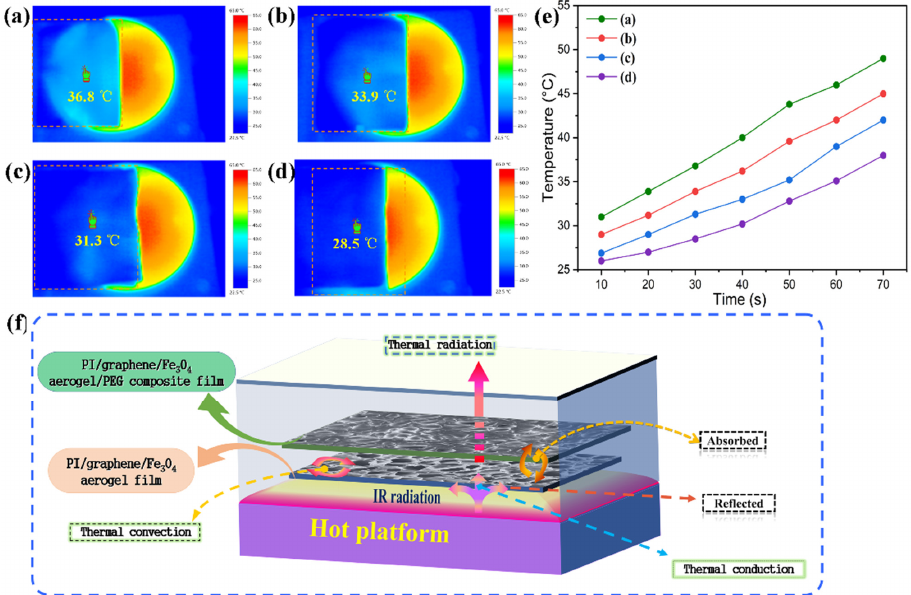
Figure 16. Infrared thermographic images of high-temperature targets partially covered with ( a ) a PI/graphene/Fe 3 O 4 hy- brid aerogel film, ( b ) a PI/graphene/Fe 3 O 4 aerogel/PEG composite film, ( c ) a lower PI/graphene/Fe 3 O 4 hybrid aerogel film and an upper PI/graphene/Fe 3 O 4 aerogel/PEG composite, and ( d ) a PI/graphene/Fe 3 O 4 aerogel/PEG composite film in the middle and two PI/graphene/Fe 3 O 4 hybrid aerogel films on the top and bottom. ( e ) The corresponding plots of surface temperature evolution as a function of time obtained from the infrared thermographic analysis. ( f ) Scheme of IR stealth mechanism for the double-layered configuration.